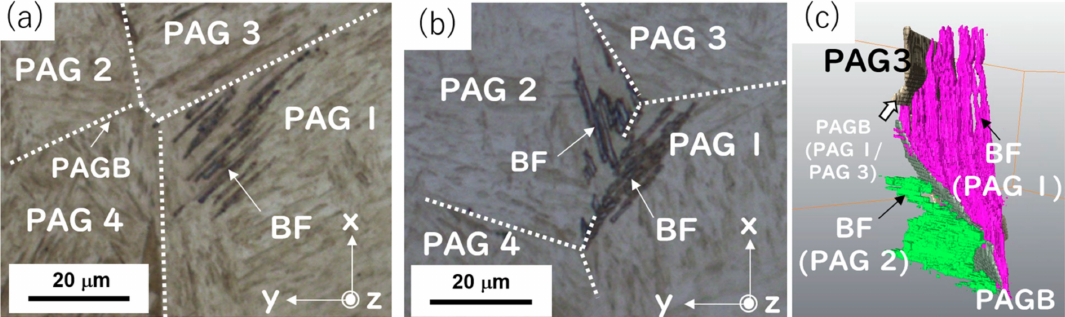
Figure 2. ( a ) The OM image of BFs, ( b ) a different layer, and ( c ) the corresponding three-dimensional